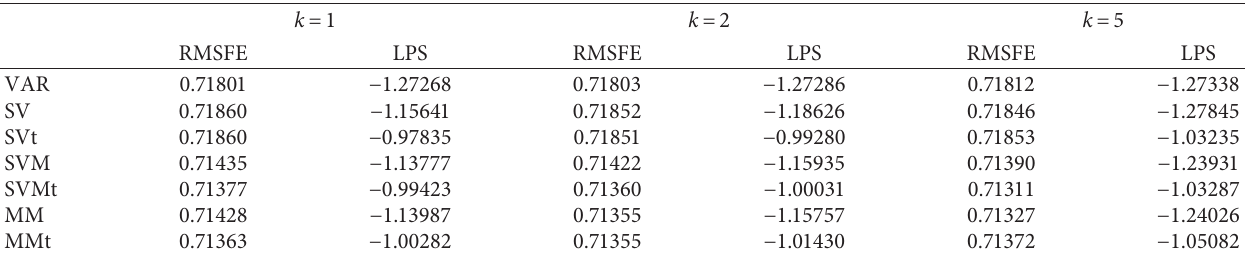
Table 8: The predictive mean and the predictive density of stochastic volatility models. k �